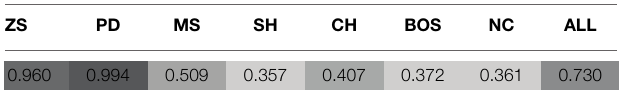
TABLE 7 | Probability of risk- vs. payoff-dominant equilibria in SH